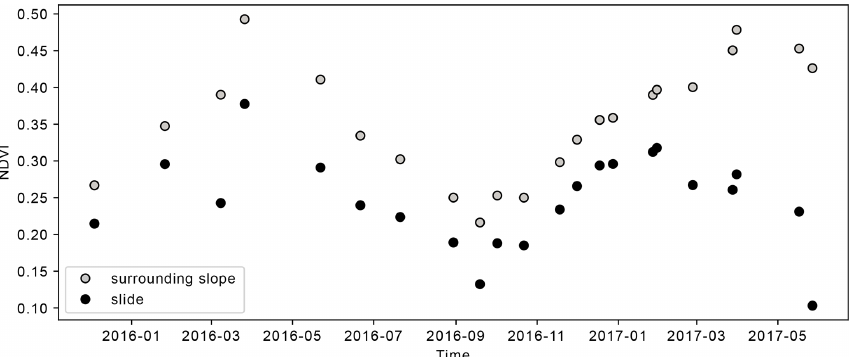
Figure 6. NDVI on the Mud Creek slide body and the surrounding slope. Note that the last data point in May 2017 is from an image acquired after the